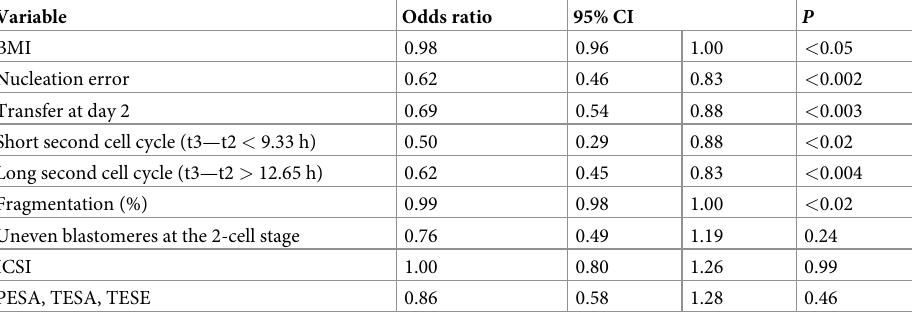
Table 1. Multivariate GAMM analysis for live